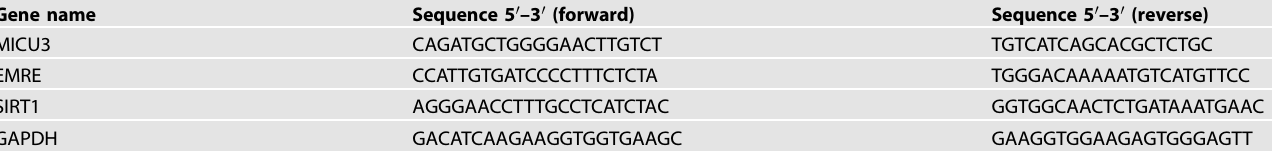
Table 1. Oligonucleotide primer sequences used in this study.